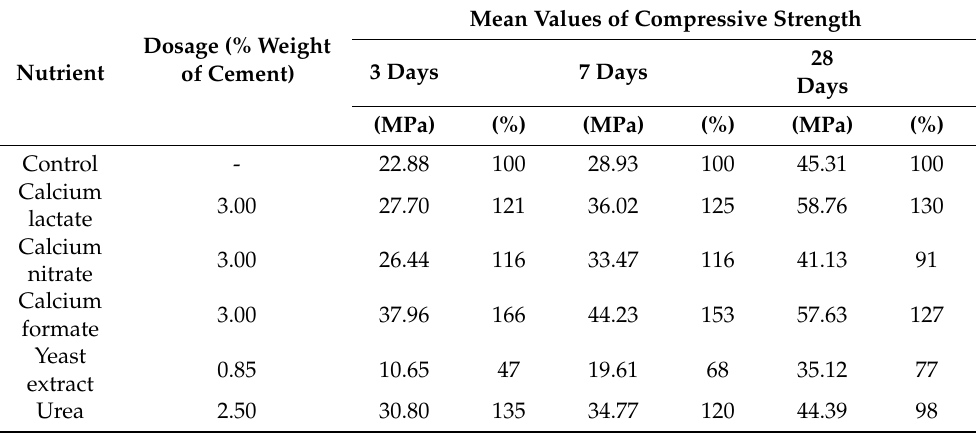
Table 5. Effect of nutritional admixtures on the compressive strength of the mortar (without bacteria)